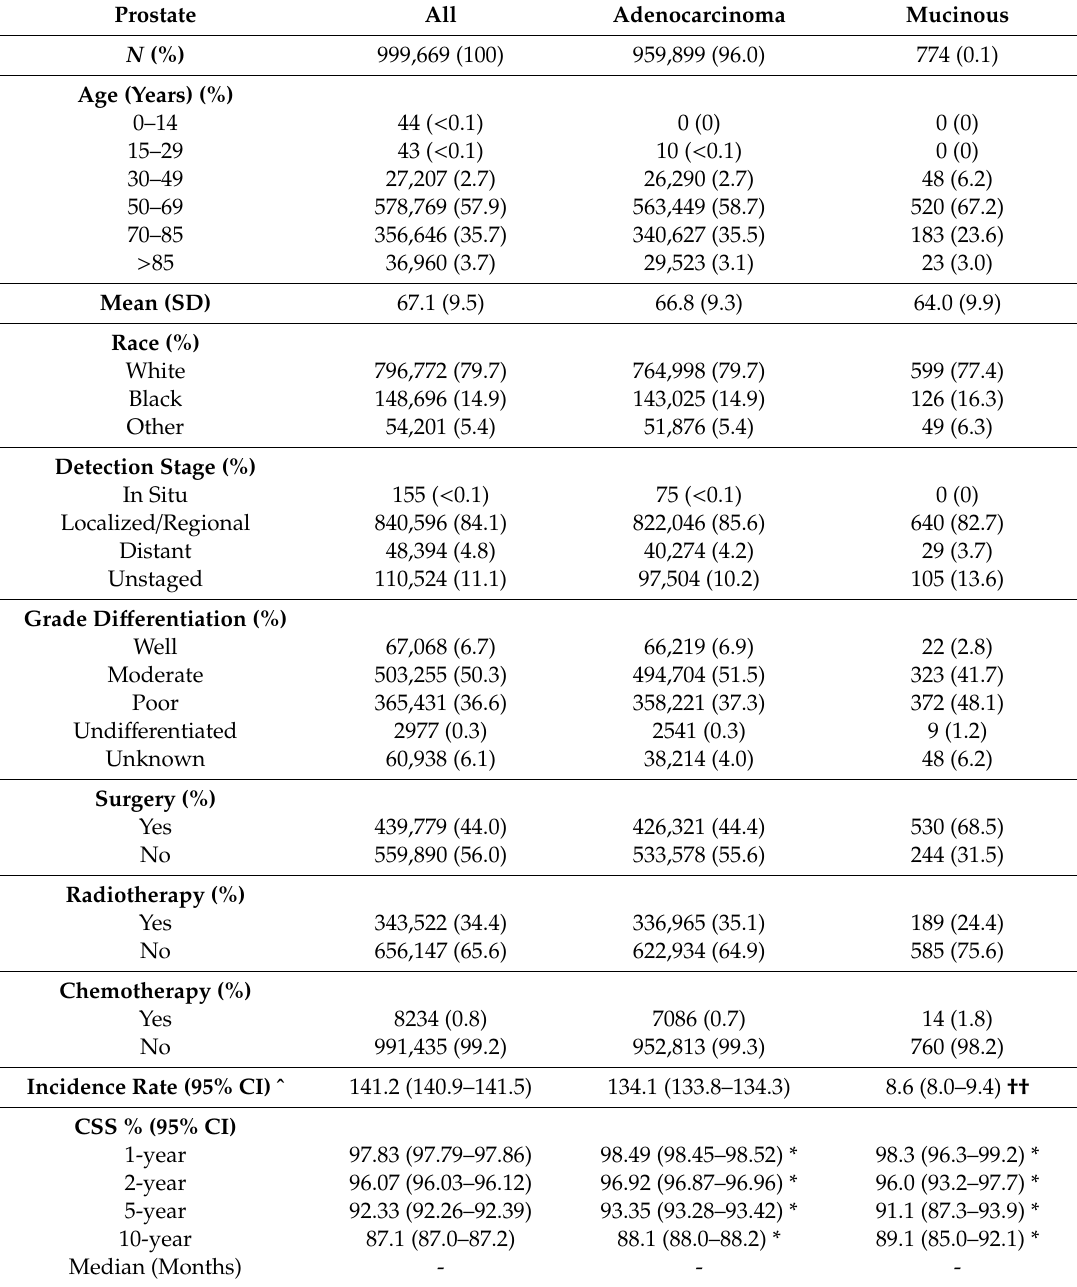
Table 21. Baseline demographics and clinical characteristics by histology for prostate